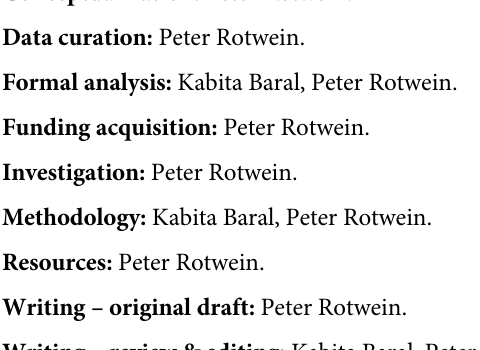
S1 Table. RNA-sequencing libraries screened for gene expression. S2 Table. Probes for screening RNA-sequencing